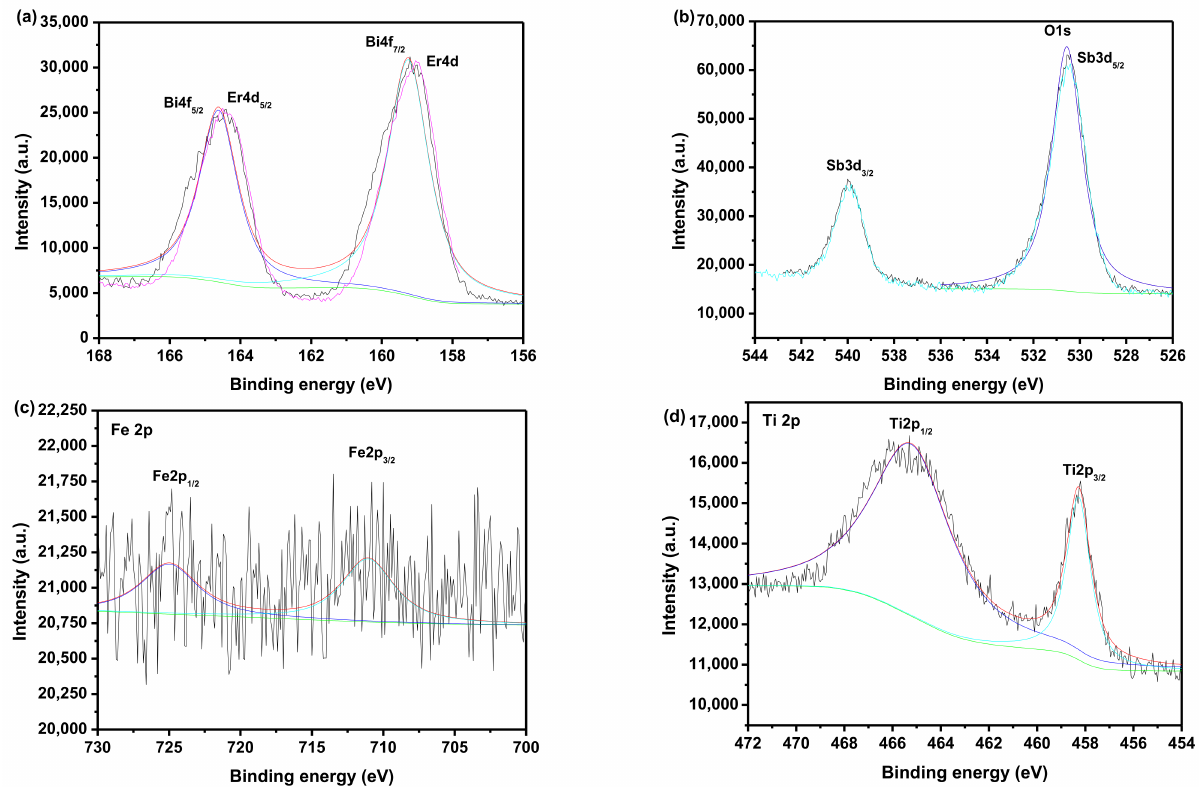
Figure 8. ( a ) XPS spectra of Er 3+ and Bi 3+ which derived from the EBHP after the reaction; ( b ) XPS spectra of O 2 − and Sb 5+ which derived from the EBHP after the reaction; ( c ) XPS spectra of Fe 3+ which derived from the EBHP after the reaction; ( d ) XPS spectra of Ti 4+ which derived from the EBHP after the reaction.